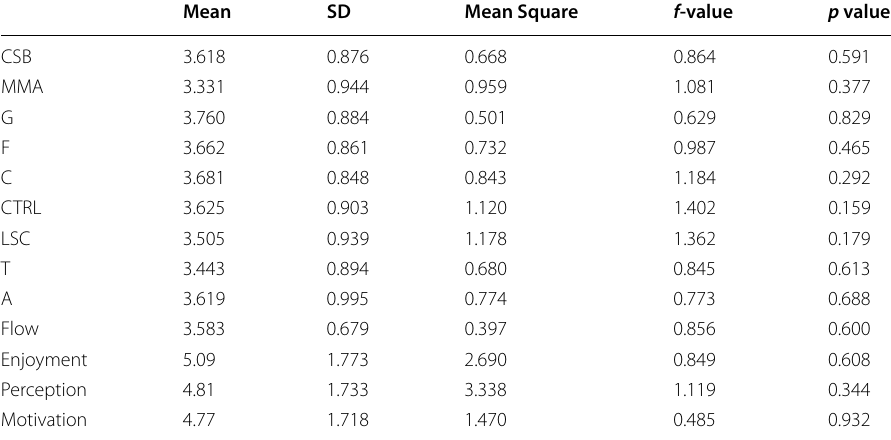
Table 4 Students experience analysis (uni-factorial